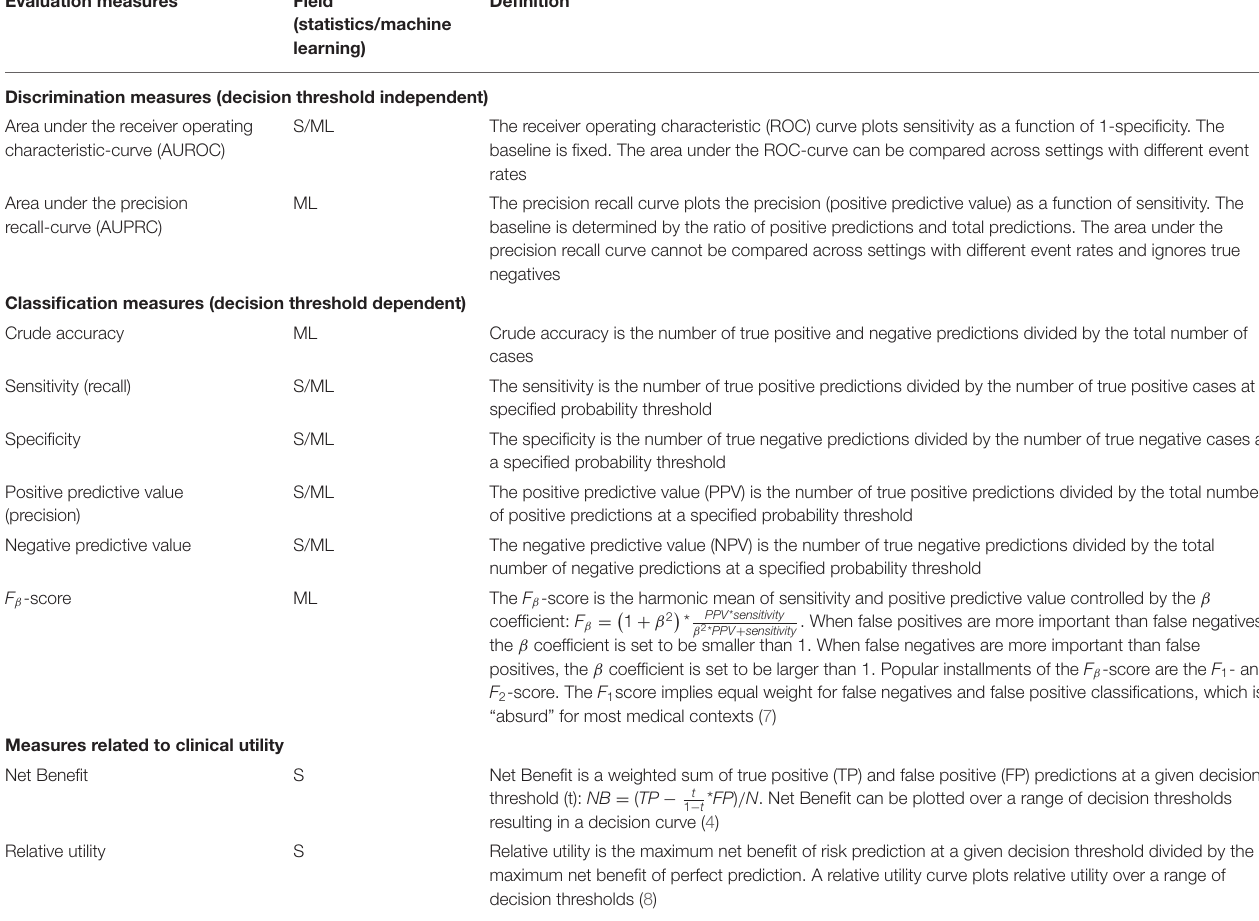
TABLE 1 | Evaluation measures from statistics and machine learning